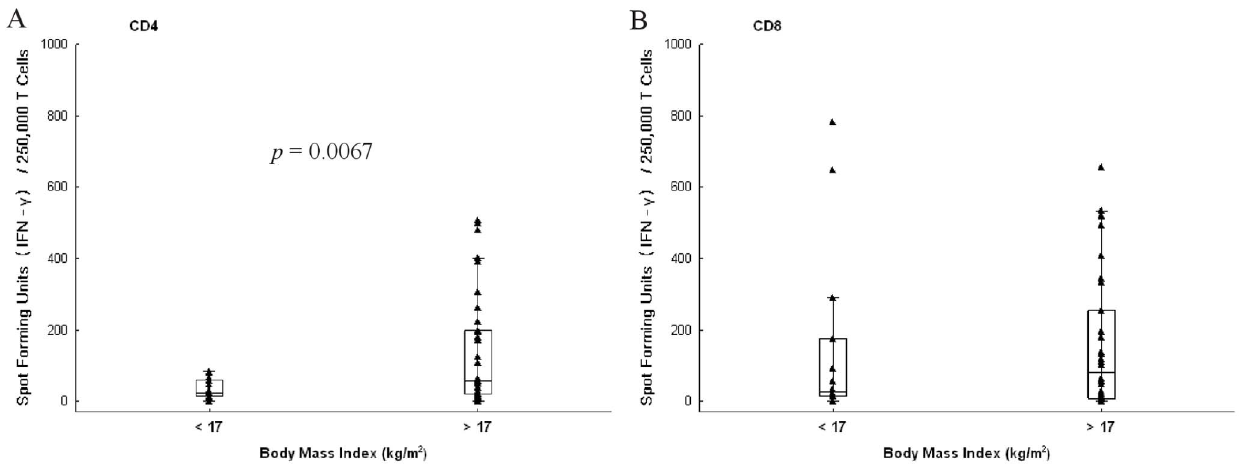
Figure 3. Mycobacteriumtuberculosis (Mtb) specific T cell responses at baseline and BMI. The magnitude of the Mtb specific T cell response by IFN- c ELISPOT to ESAT-6 and CFP-10, and reported in spot forming units/250,000 T cells, is shown at baseline for the Mtb specific CD4 + response (A) and the Mtb specific CD8 + response (B) for BMI # 17 (n=14) and . 17 (n=34). A negative binomial model was used to assess differences in the Mtb specific T cell responses and BMI # 17 and . 17. Raw data, shown as a triangle, surrounded by the box demonstrates the distribution of 25–75% of the data, with the whiskers representing the non-outlier data, and the horizontal line depicting the median.